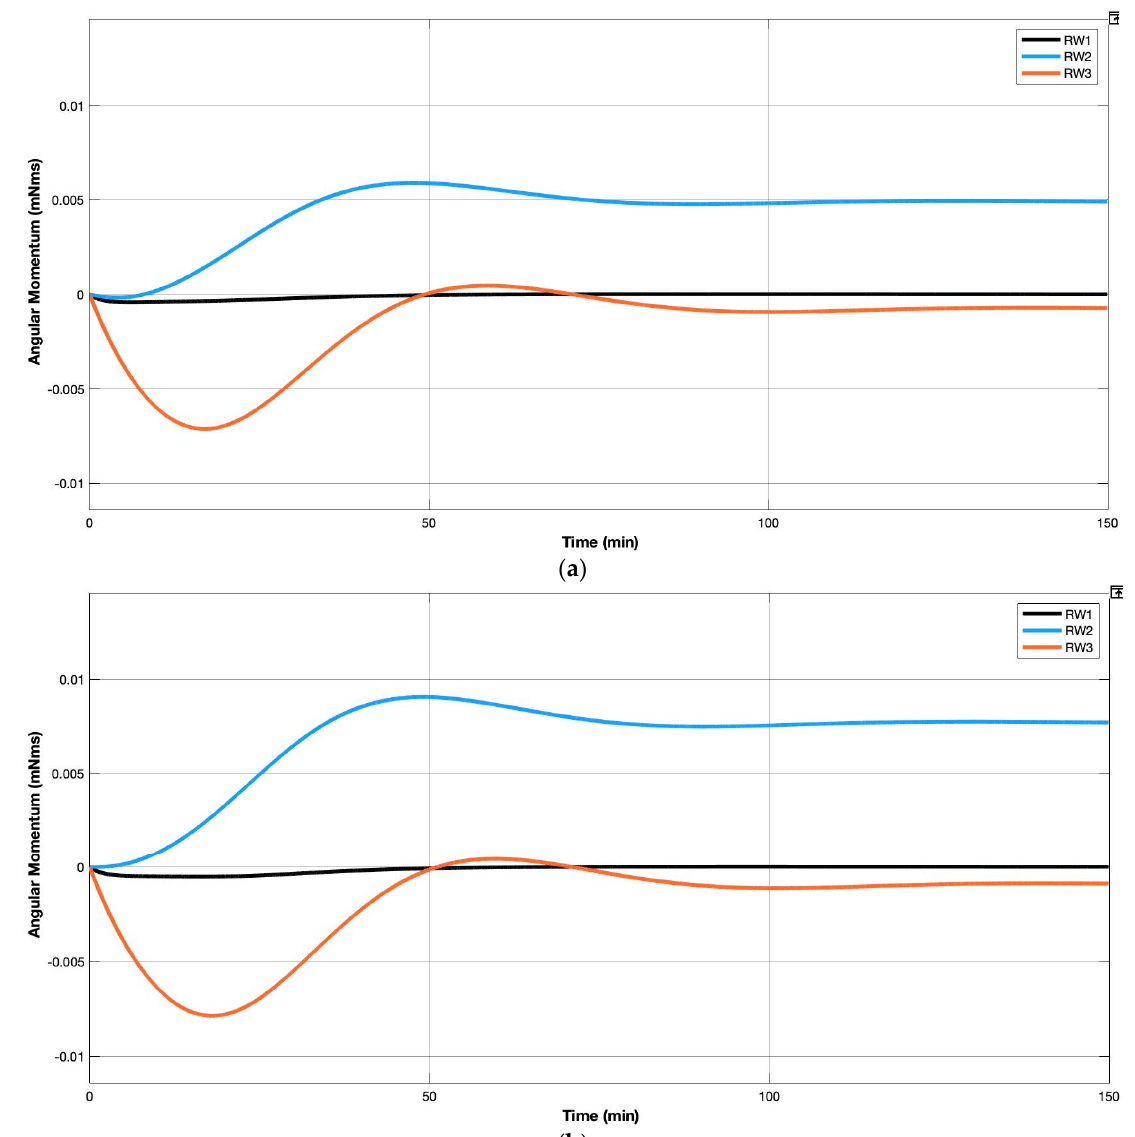
Figure 10. Quaternion response for ( a ) Vilnius and ( b ) Aalborg.